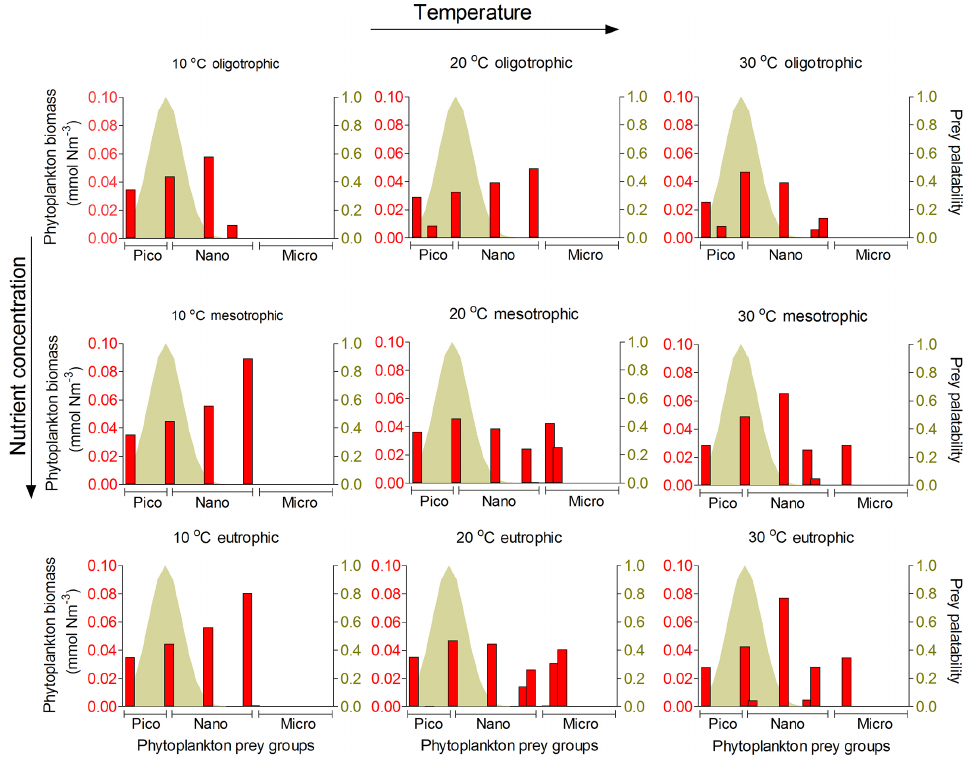
Figure 8. Model results of resource competition for the prolocular stage (20µm) of planktonic foraminifera in the food web version. Left axis (red columns): biomass (mmolNm − 3 ) of phytoplankton size groups. Right axis (coloured shadow): prey palatability of planktonic foraminifera using a σ = 0 . 5. A total of 6 pico- (0.6–2.0µm), 10 nano- (2.6–20µm) and 9 microplankton groups (25–160µm) are included in the model